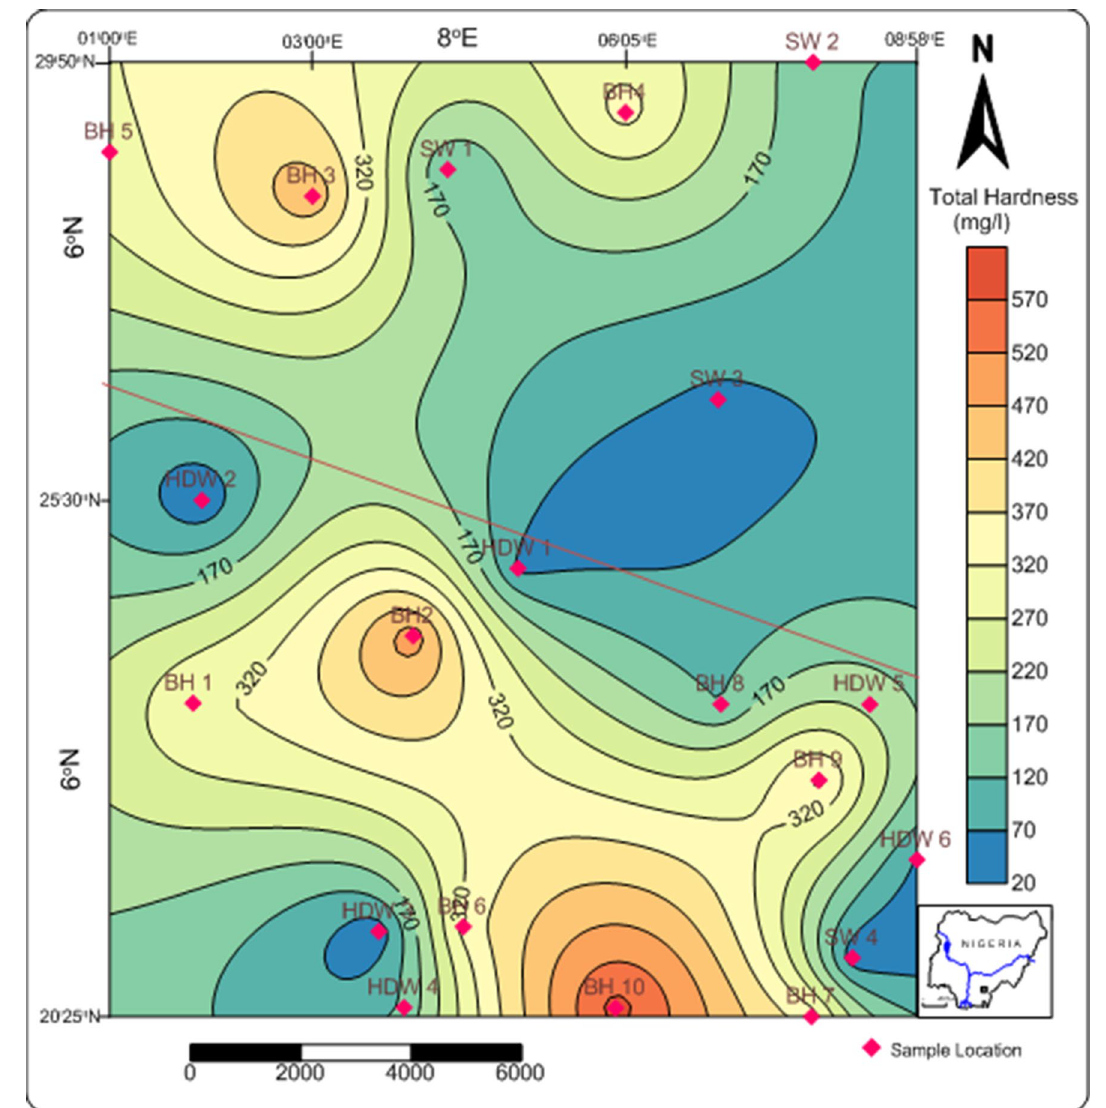
Fig. 25 Map showing the dispersion trend of total hardness (TH). Note : Perpendicular line indicates groundwater